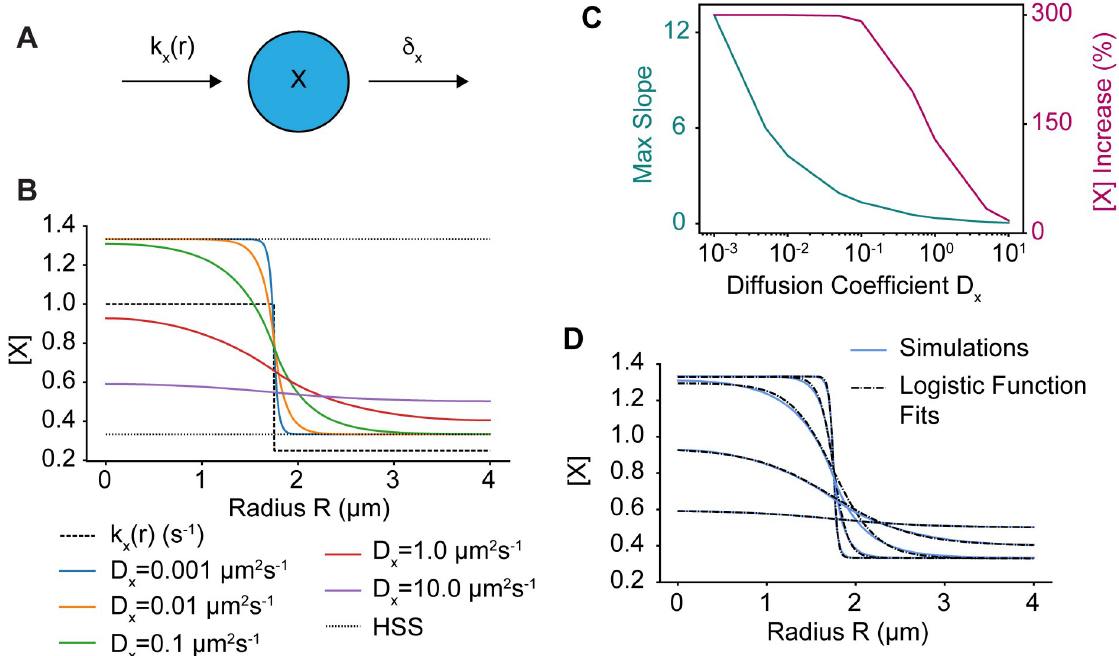
. B ) Simulations of the x